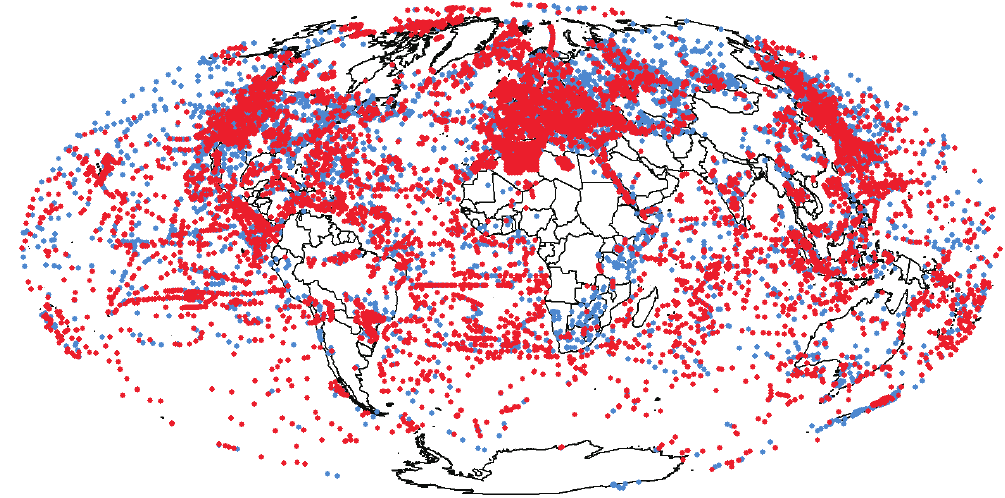
Fig. 2. As in Fig. 1a, but broken down into those points included in PHJ93 (blue) and additional points (red).